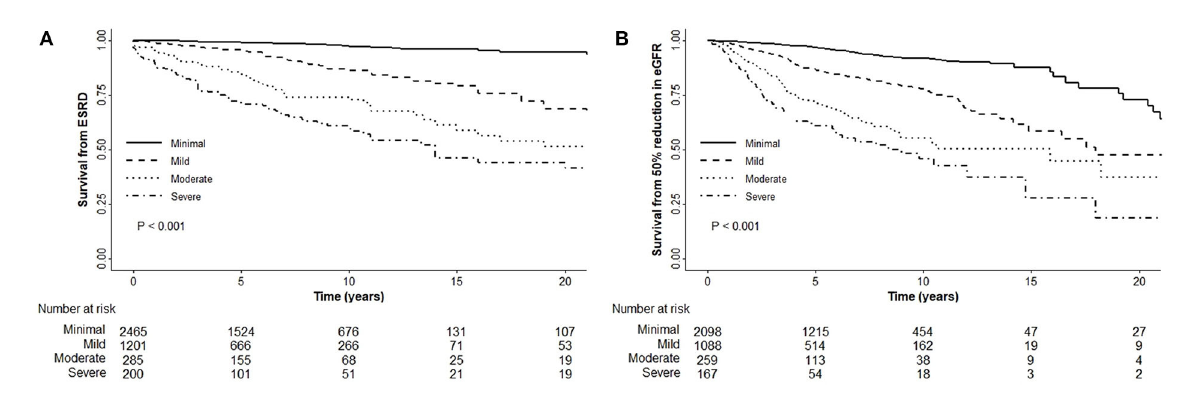
FIGURE1 Renal outcomes with the chronicity grading. (A) Chronicity grading with ESRD progression. (B) Chronicity grading with 50% reduction in